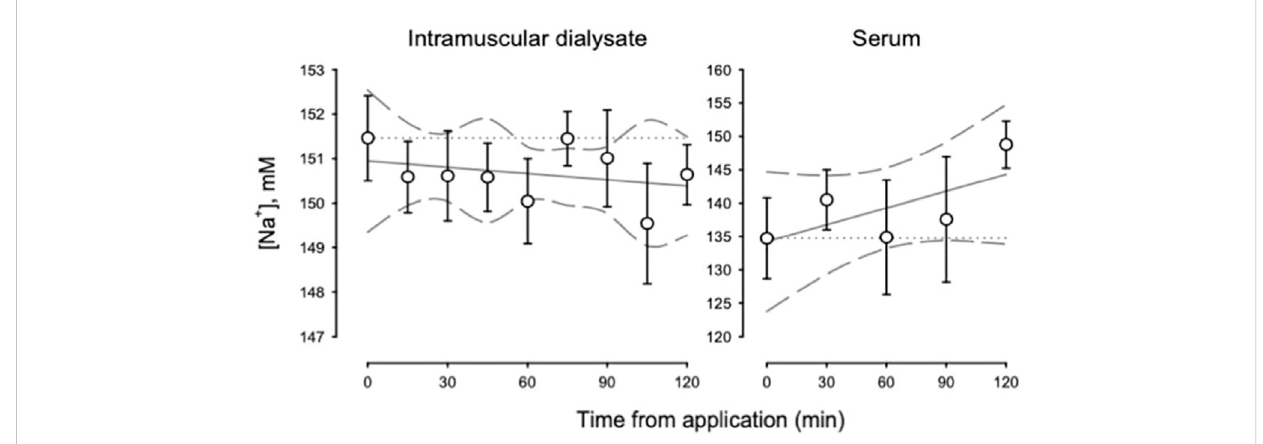
[Na + ] for intramuscular dialysate (left panel) and serum (right panel) during the primary study from baseline to end-of-study.